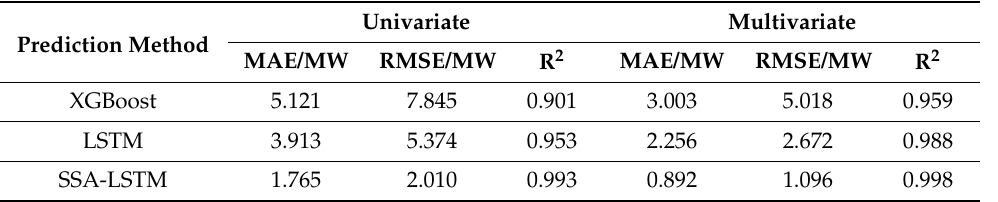
Table 5. PV output forecasting